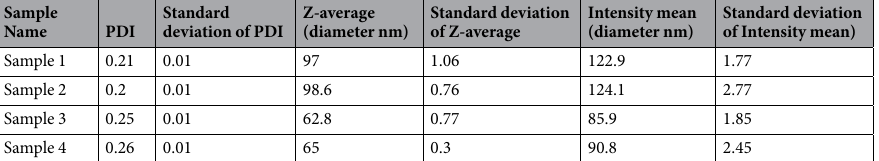
Table 1. Results of dynamic light scattering.